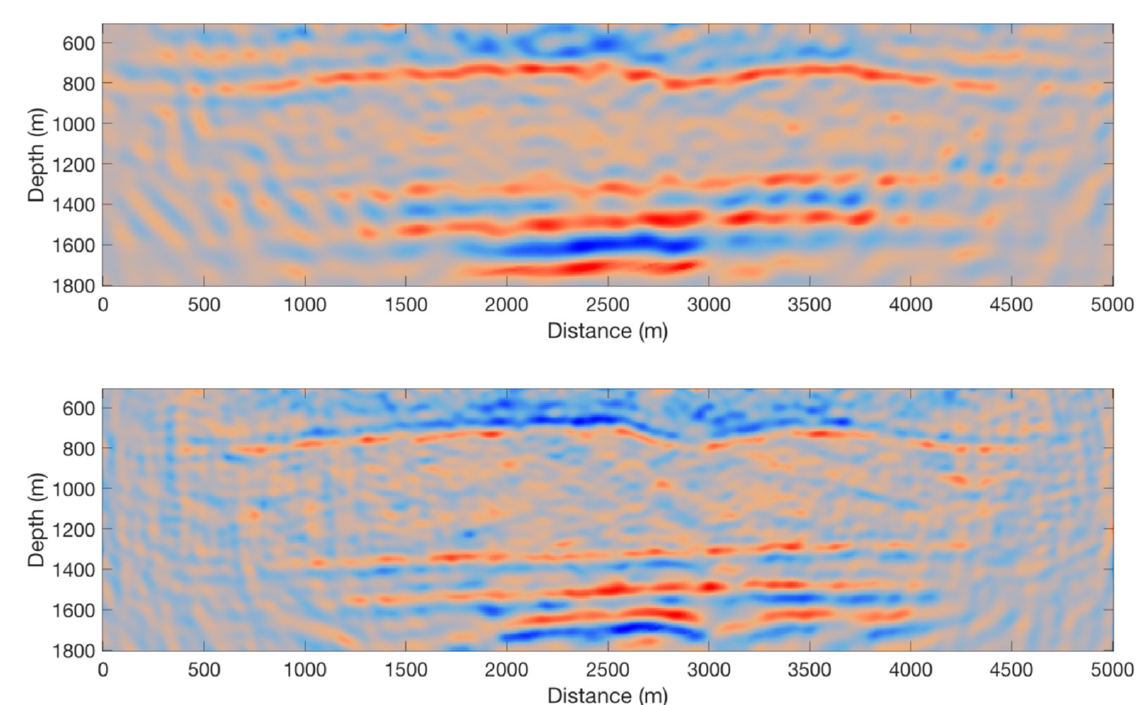
(cid:0) (cid:1) V p , V s